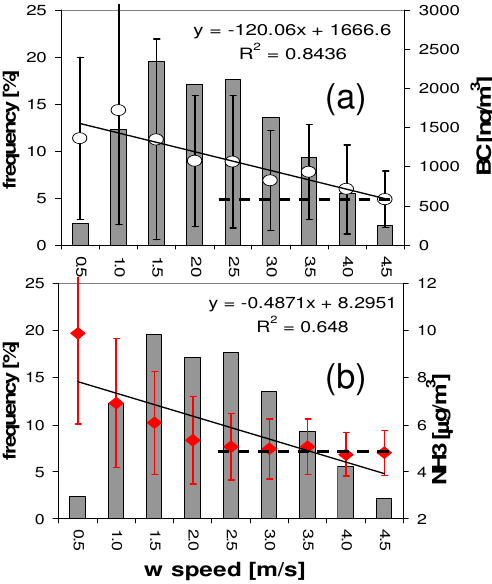
Fig. 8. Correlation between the frequency distribution (%) of scalar wind velocity (ms − 1 ) and (a) BC concentration and (b) NH 3 con- centrations at